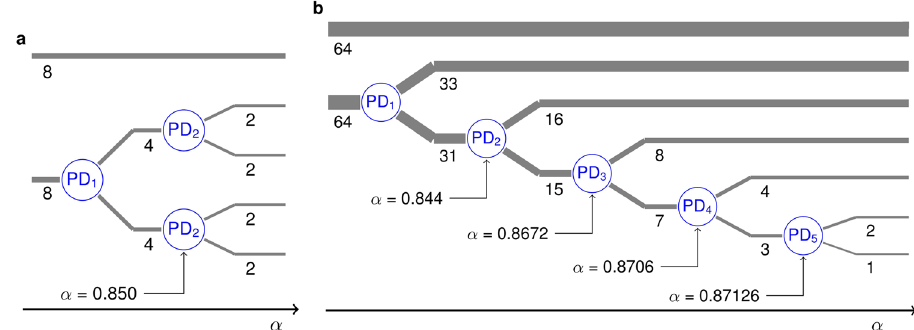
Fig. 8 Cluster splitting in the time-discrete maps. a Schematic portrayal of the period-doubling cluster splittings as α is increased for β = 0.15 and an initial 8 − 8 solution. b Like a for a possible cluster-splitting cascade for N = 128 and β = 0.15. The schematics are based on the quantitative results shown in Supplementary Figs. 9 and 10, respectively, and described in Supplementary Note 5.